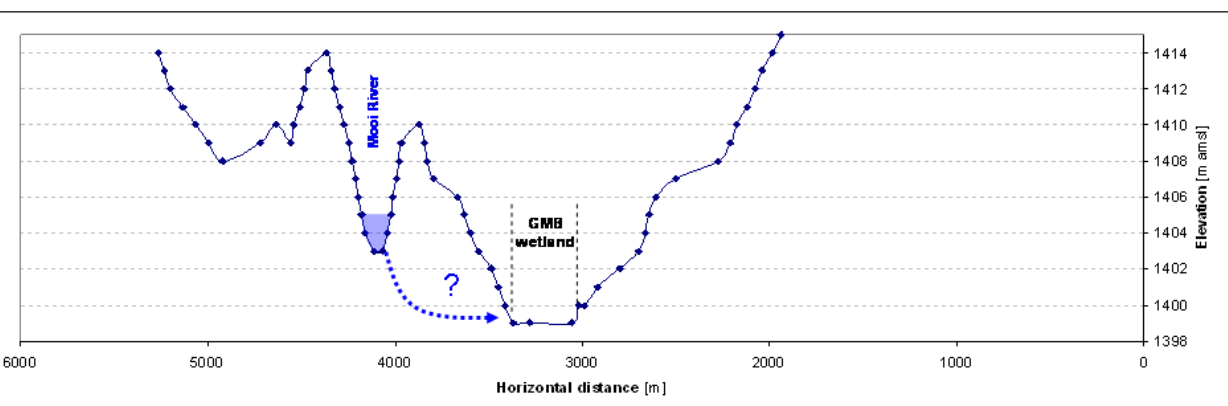
Figure 5. Relief cross section indicating a hydraulic gradient between the upper Mooi River and the lower part of the GMB wetland that may possibly drive subterraneous bed loss from the Mooi River into the wetland (100-times vertical